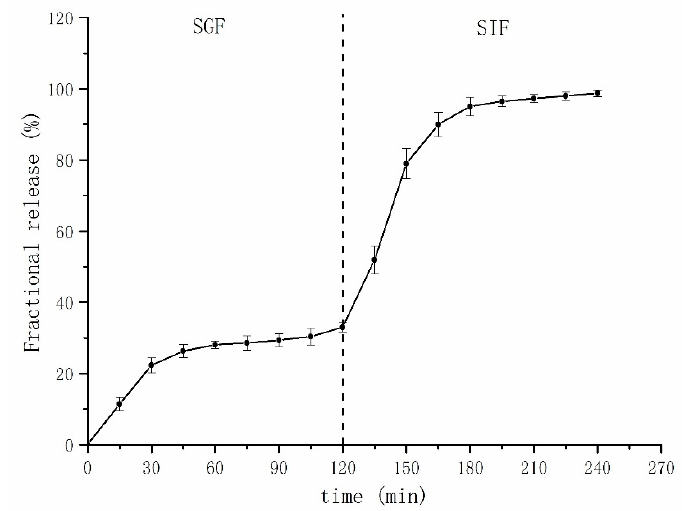
Figure 9. Release rate of microcapsules under in vitro digestion.